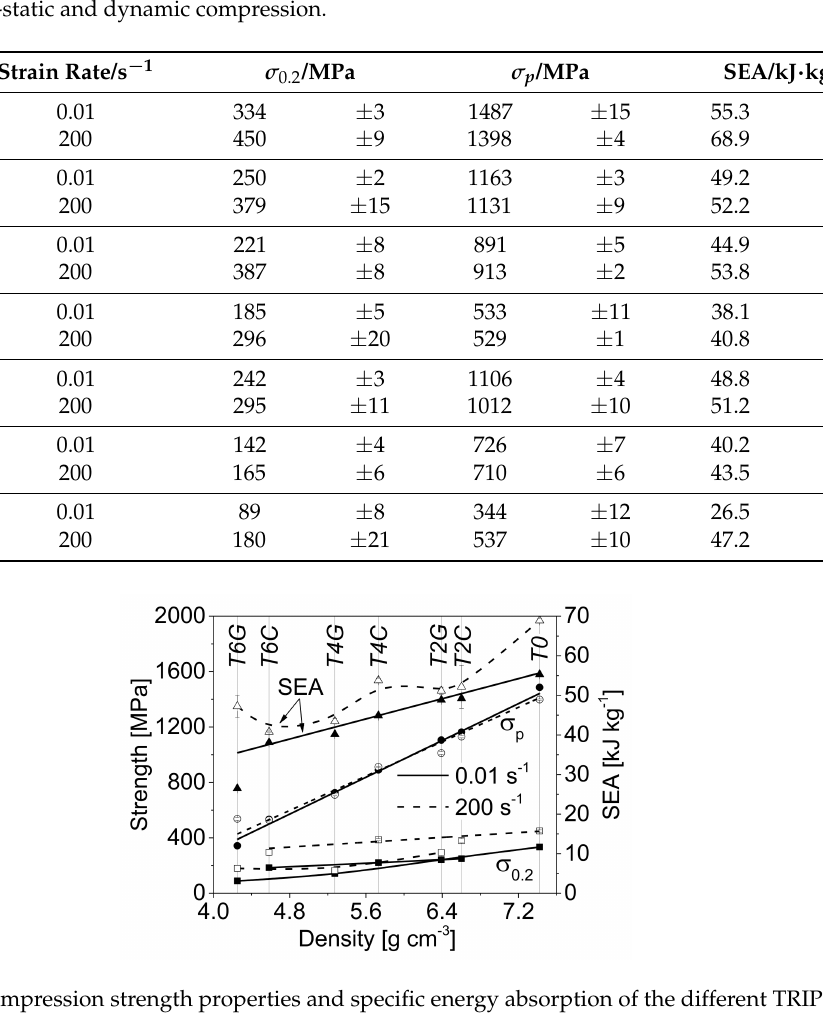
Figure 6. Compression strength properties and specific energy absorption of the different TRIP-steel matrix syntactic foams and the matrix reference material with respect to strain rate (0.01 s − 1 , 200 s − 1 ) and